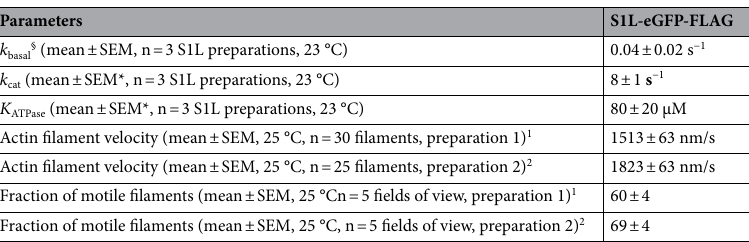
Table 1. Summary of ATPase and IVMA results. § measured (NADH-coupled assay). * error of the fitting process of Eq. (1) including data from 3 independent preparations (cf. Fig. 3B). 1 Single affinity